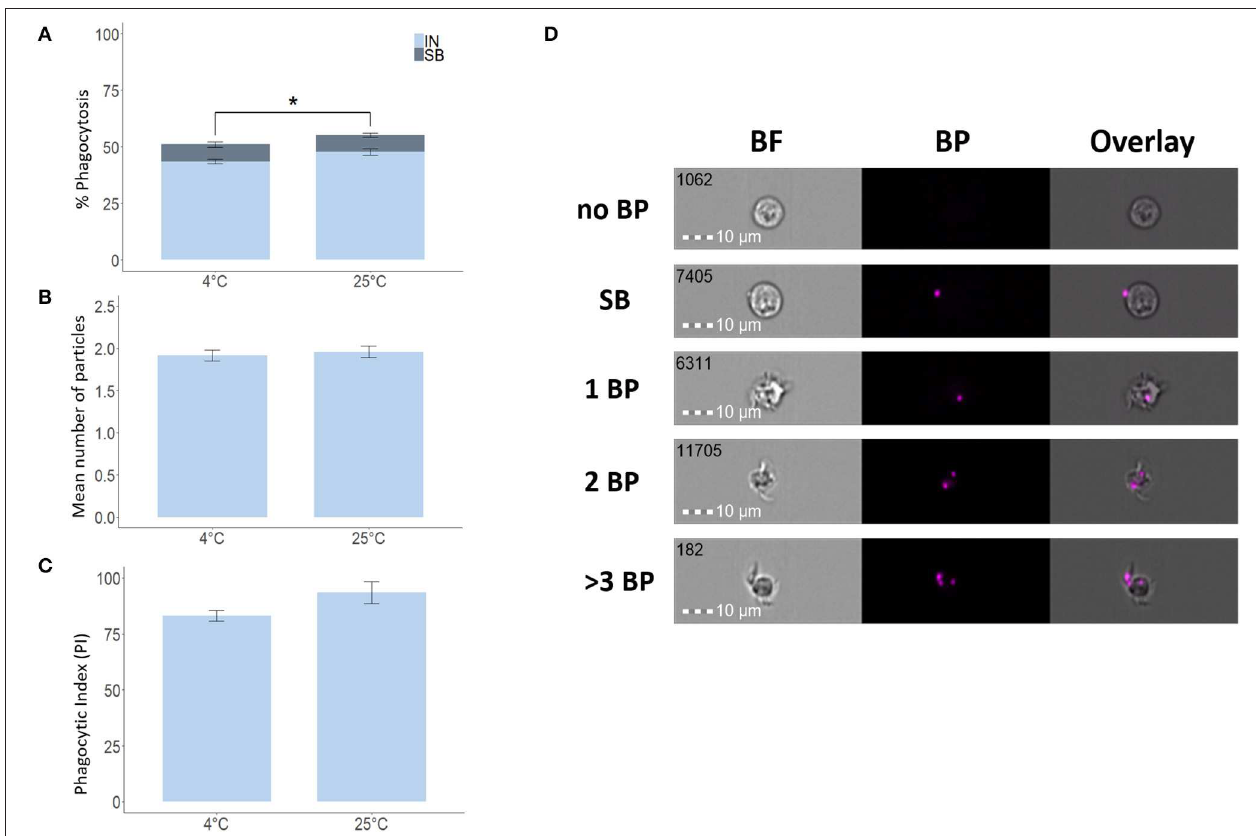
FIGURE 6 | Phagocytosis of Nile tilapia head kidney macrophages incubated at different temperatures. Percent of phagocytic cells (A) , mean number of particles ingested per phagocytic cell (B) and phagocytic index, PI (C) . Representative cell images that show cells with no BP, SB, and 1BP, 2BP, and > 3BP (D) . Statistically significant differences ( p < 0.05) are indicated using asterisks. Bar plots show the mean ± SD. Sample size = 6. All cell images were captured with 40 × objective. Scale bar = 10 µ m. IN, internalization; SB, surface-binding particles; 1 BP, 2 BP, and > 3 BP, 1–3 internalized bio-particles; BF,